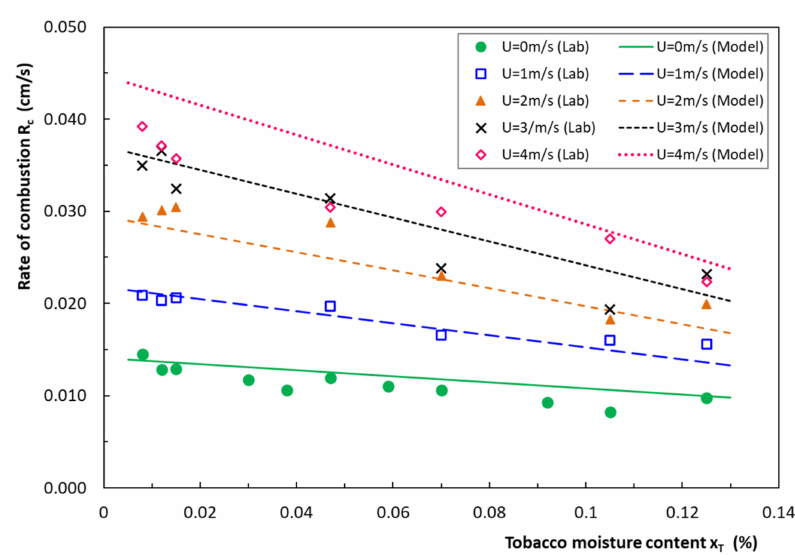
Figure 7. Rate of combustion of Lower Ignition Propensity (LIP) cigarettes as a function of moisture content x T for different values of flow velocity U (m.s − 1 ). The dashed lines correspond to the application of the model (Equation (44)) for values of airflow velocity U = 0, 1, 2, 3 and 4 m.s − 1 . Therefore we